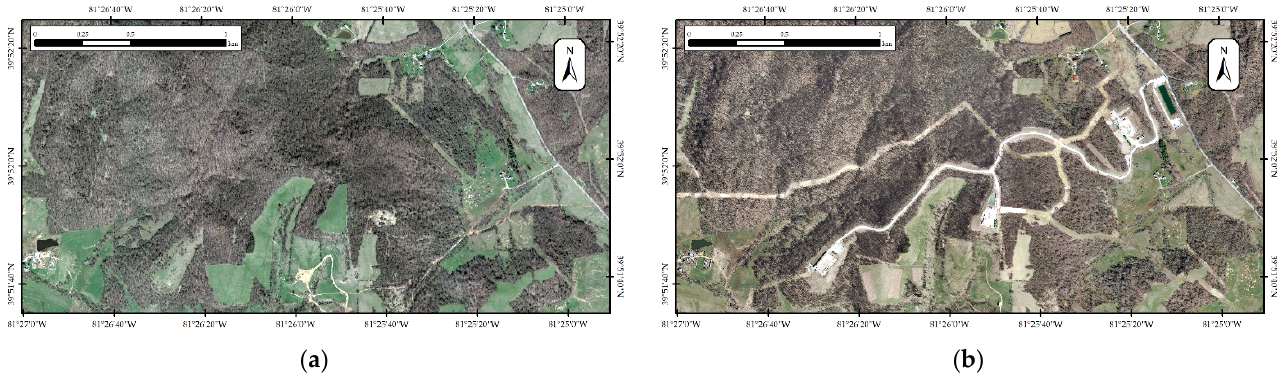
Figure 2. The landcover changes caused by the unconventional shale oil and gas extraction activities: ( a ) before the construction, (OSIP aerial image, captured in 2007); ( b ) after the construction (OSIP aerial image, captured in 2014).